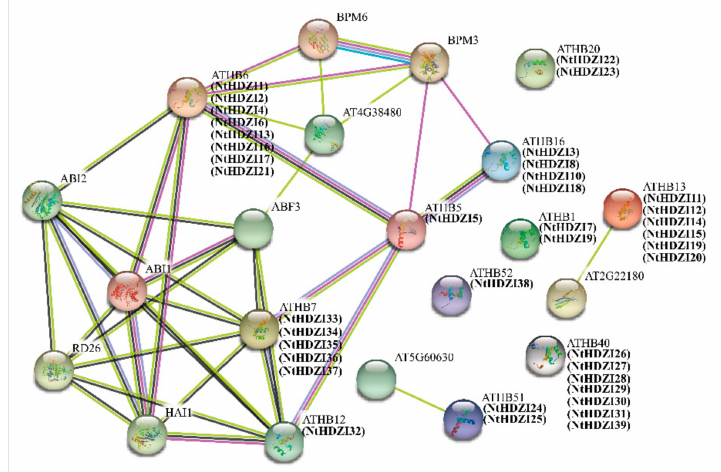
Figure 4. The prediction of the interaction network of NtHD-Zip I proteins based on the interactions of their orthologs in Arabidopsis